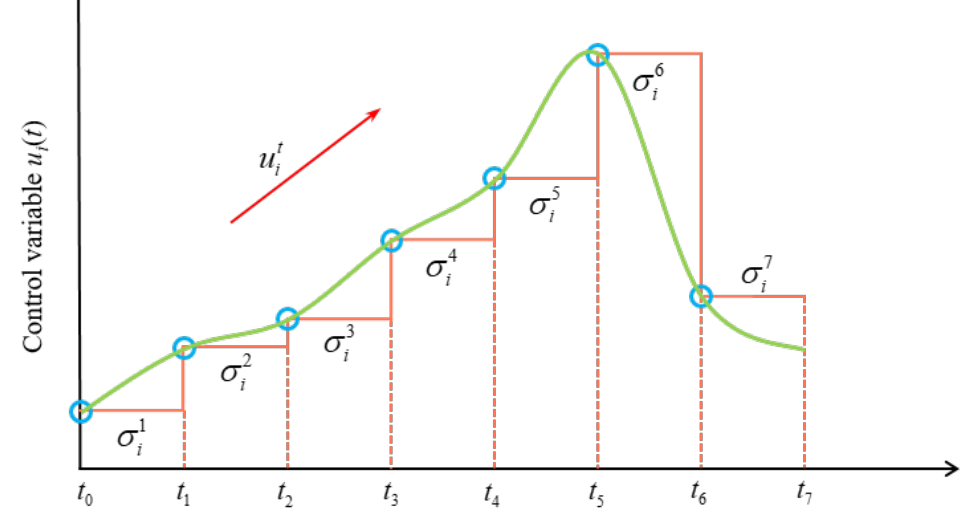
Figure 1. Piecewise constant approximation of CVP method.